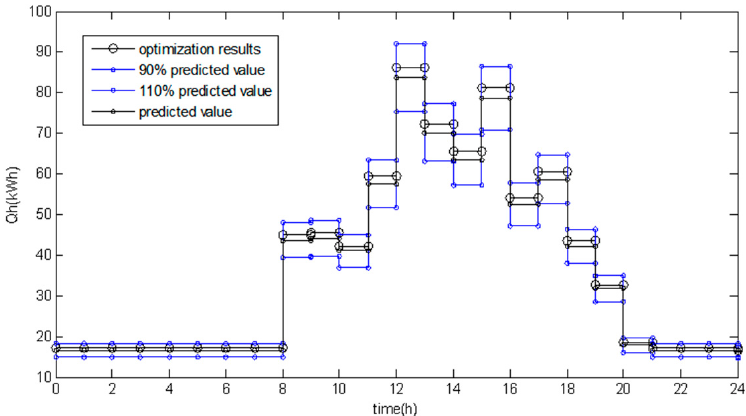
Figure 12. Heat load requirements and their grey domain values.